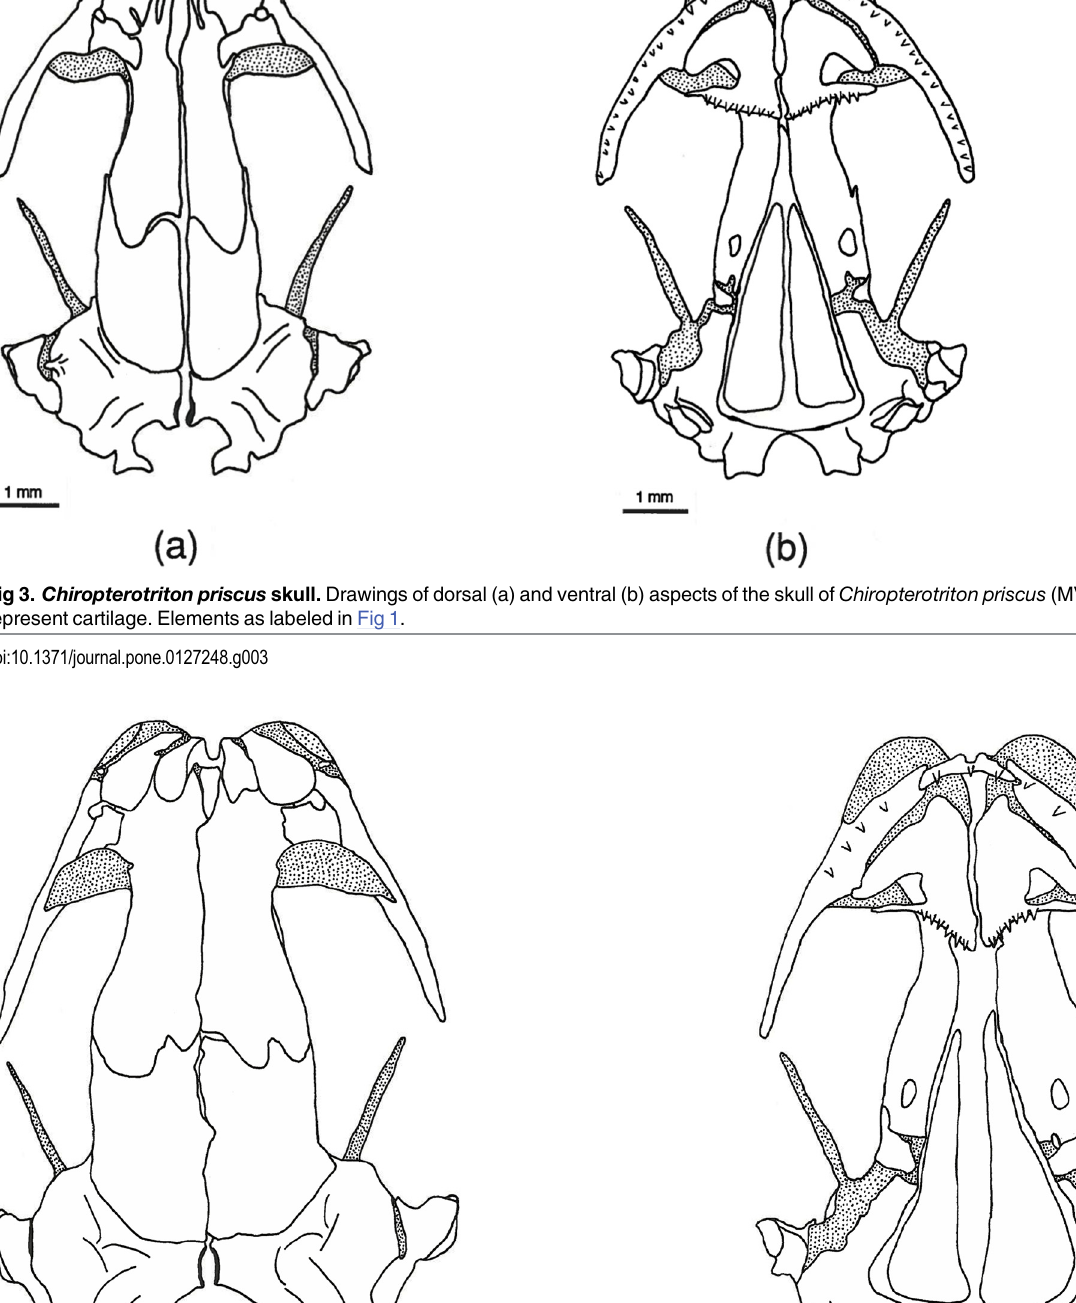
PLOS ONE | DOI:10.1371/journal.pone.0127248 June 10,